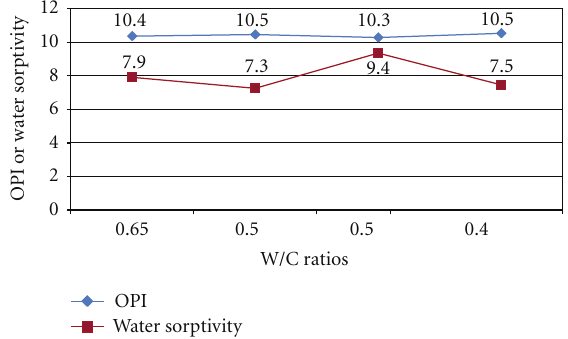
Figure 5: OPI and water sorptivity results for CEM IV/B-V 32.5R at di ff erent w/c